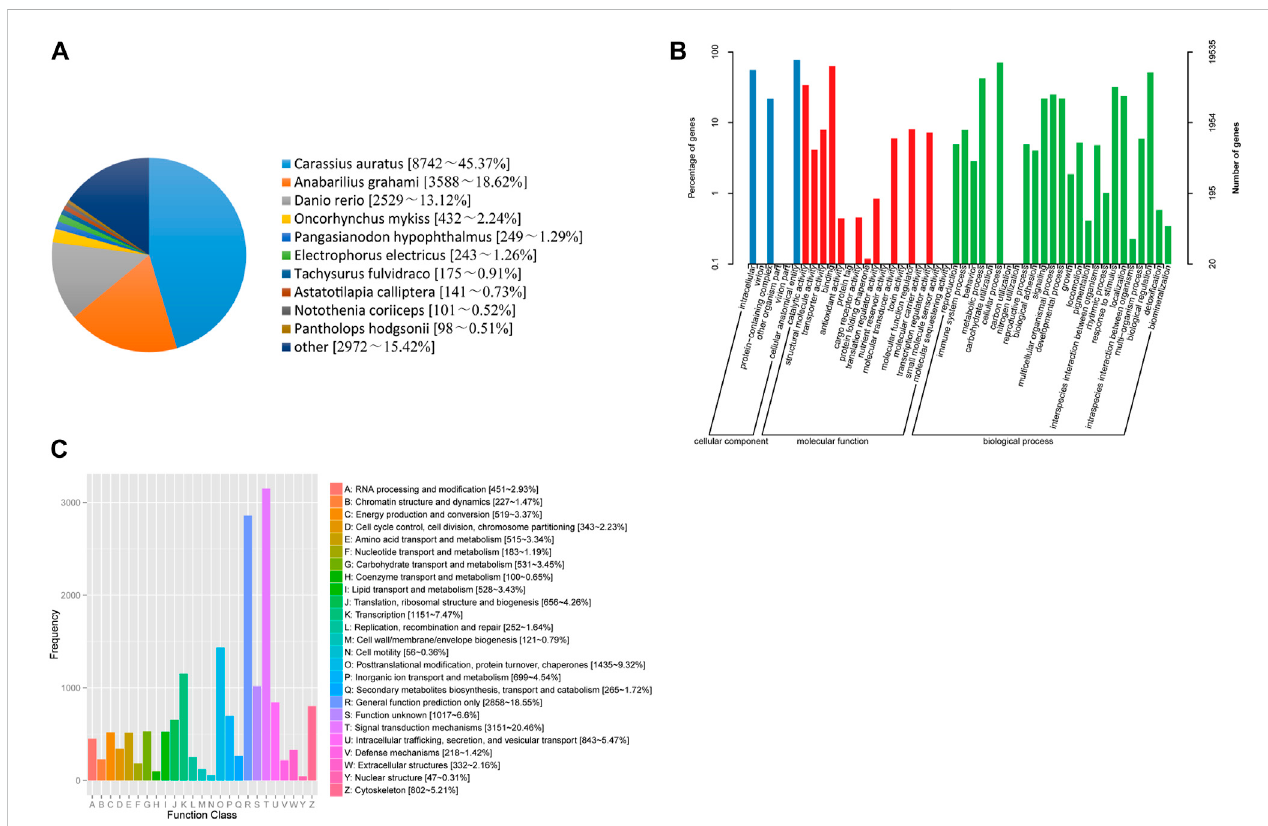
FIGURE 1 (A) Species distributionresults of asimilaritysearch ofunigenesagainst Nrdatabases. (B) Functional classi fi cation ofassembleduniquesequences based on GO terms. (C) Functional classi fi cation of assembled unigenes based on